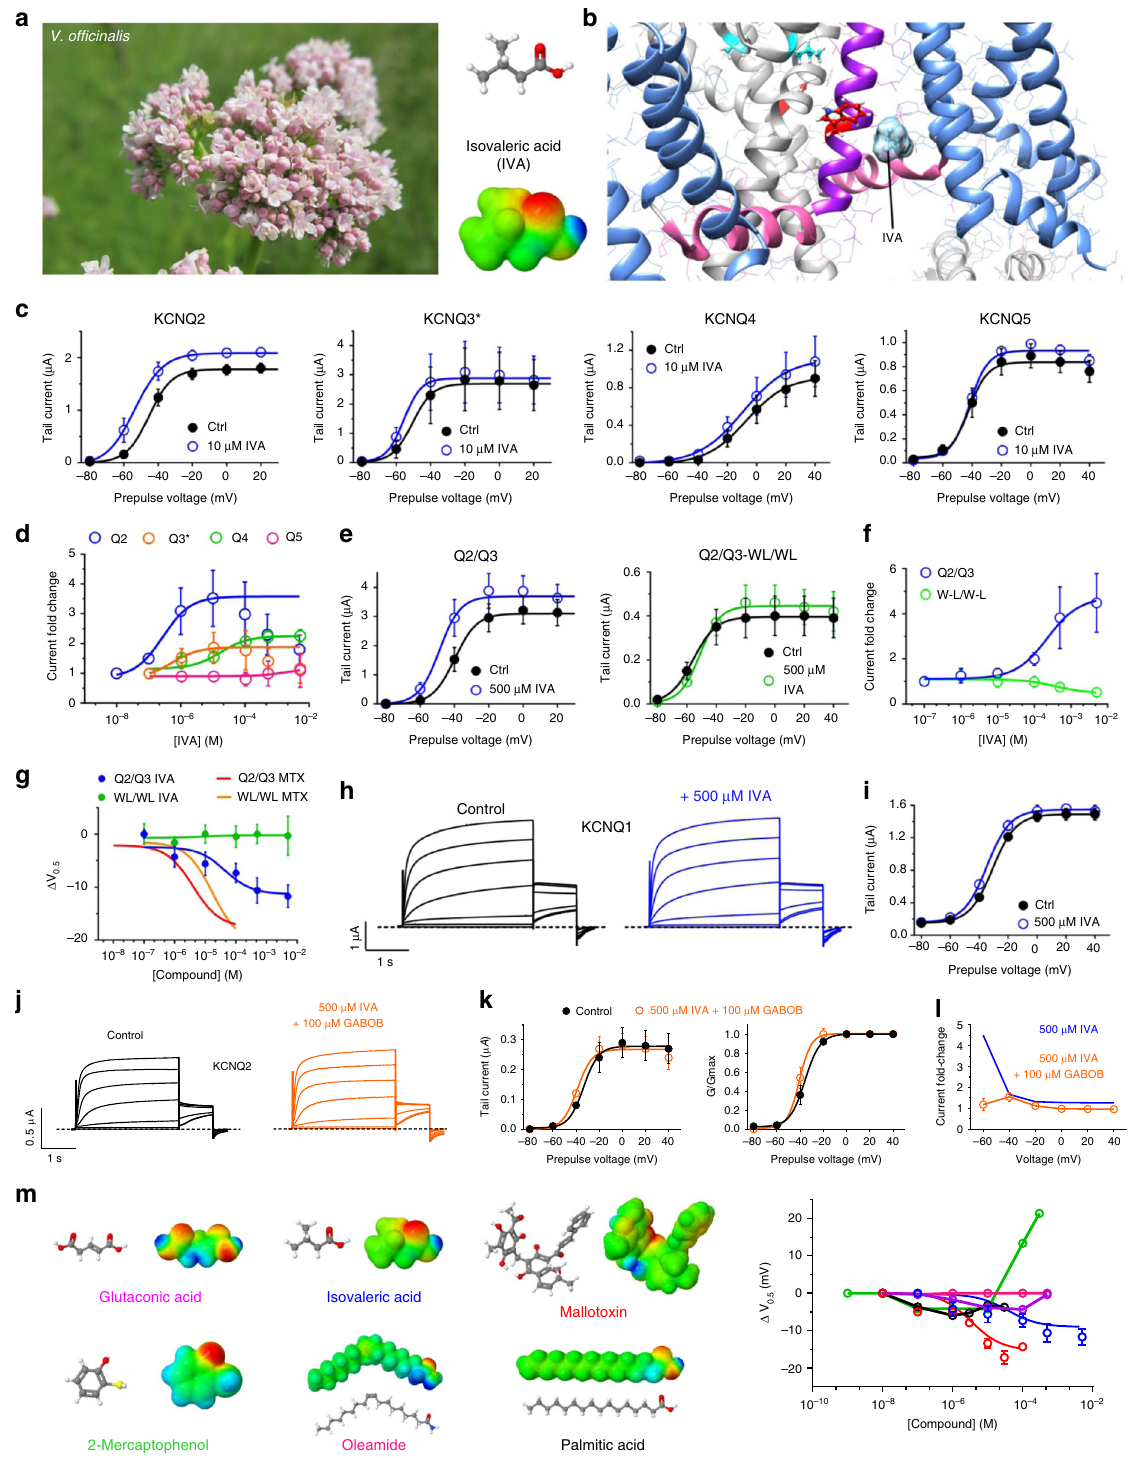
V 0.5 of activation by − 23 mV (Fig. 6a – c; Supplementary Table 31). MTX and IVA in combination speeded KCNQ2/3 activation and slowed its deactivation >twofold (Fig. 6d; Sup- plementary Tables 32 and 33). Strikingly, the IVA + MTX com- bination synergistically increased KCNQ2/3 current at − 60 mV by 24-fold, compared to ~ fi vefold for either component alone (Fig. 6e). A cocktail of the fi ve KCNQ2/3-active components of M. oppositifolius leaf extract produced a similar KCNQ2/3 V 0.5 activation shift to that of IVA + MTX, again suggesting these two NATURE COMMUNICATIONS| (2018) 9:3845 |DOI: